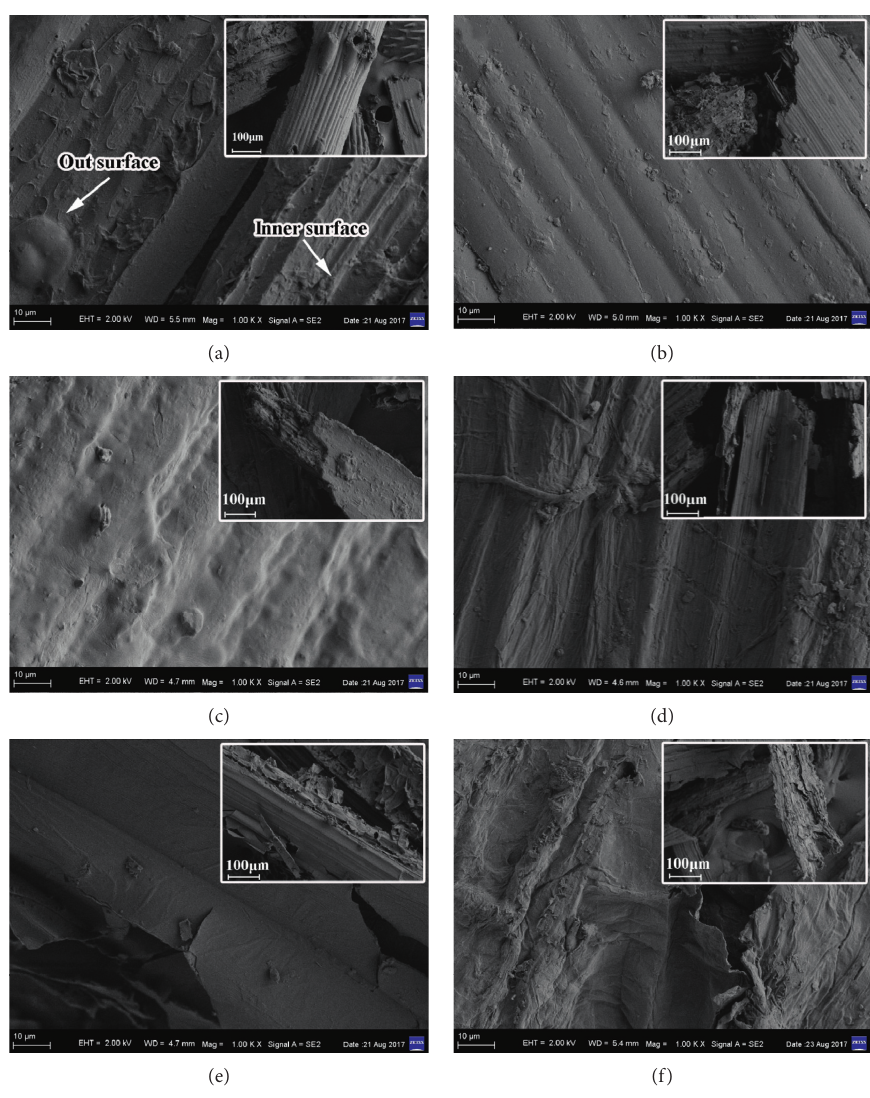
Figure 6: SEM graphs of wheat straw fibers